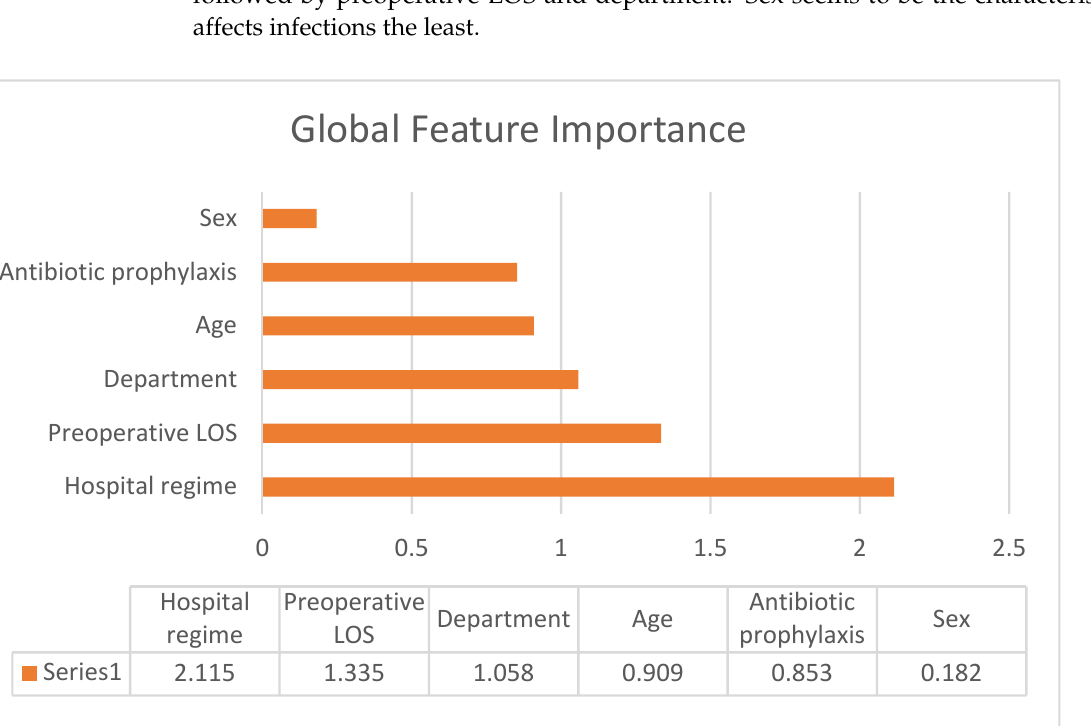
7 Table 5. Confusion Matrix (RF). Real/Predicted